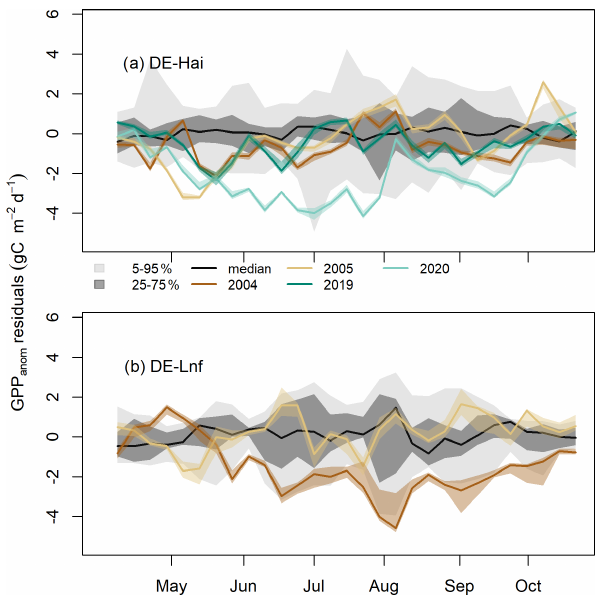
Figure 3. Residuals of GPP anomalies at the seasonal scale in legacy years at (a) DE-Hai and (b) DE-Lnf. Residuals of GPP anomalies were characterised by observed minus predicted GPP anomalies (GPP anom residuals). The coloured lines and bands show the median and 5th–95th percentile GPP anom residuals of ensemble model runs (see Sect. 3.4), respectively. Negative residuals corre- sponded to more negative or less positive GPP anom than would be expected given the climate in that year, indicating negative lega- cies of drought, while positive residuals corresponded to less neg- ative or more positive GPP anom , indicating beneficial legacies of drought. The model uncertainties (dark and light grey shaded areas, respectively) are characterised by the 25th–75th and 5th–95th quan- tile ranges of GPP anom residuals in non-legacy years. The black line represents the median of GPP anom residuals in non-legacy years. The ticks denote the start of each month.